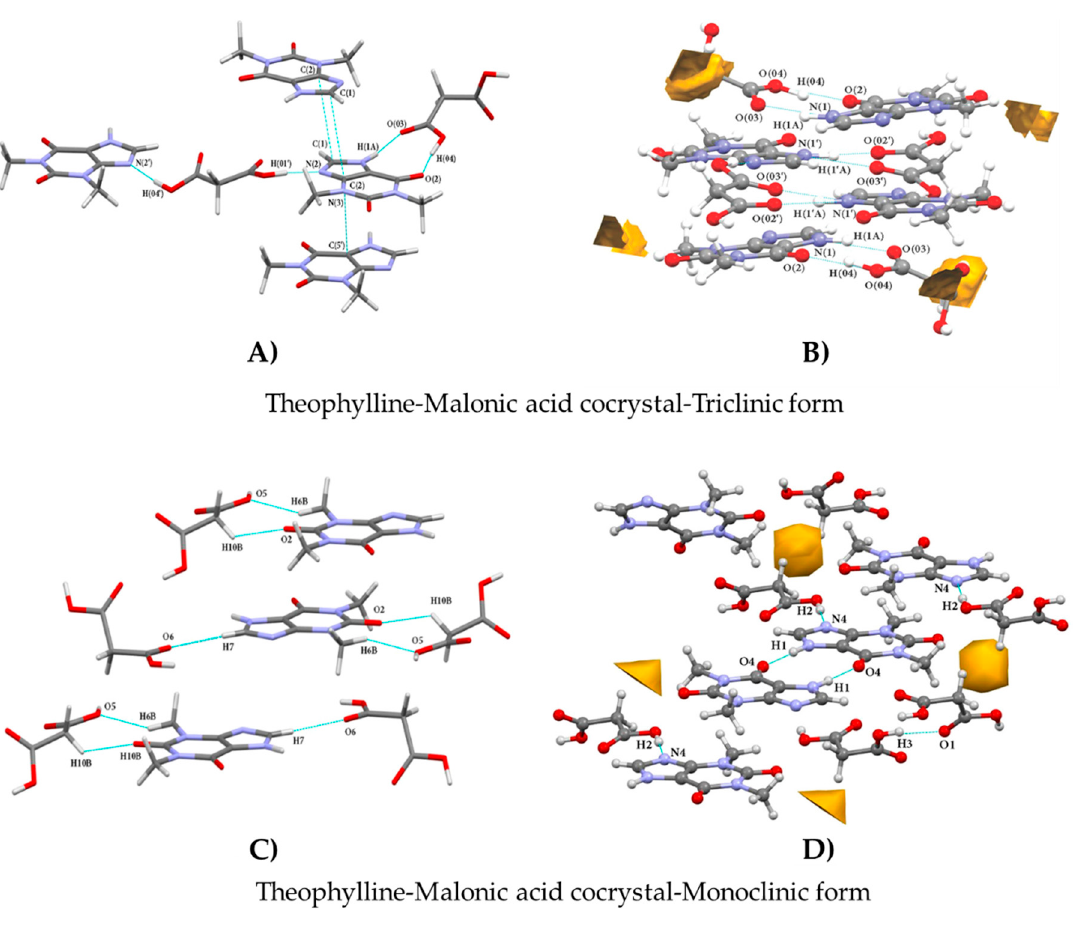
Figure 10. ( A , C )—Hydrogen bonding and aromatic stacking, ( B , D )—Void space present within the co-crystals. Reprinted (adapted) with permission from [28]. Copyright 2021, American Chemical Society.